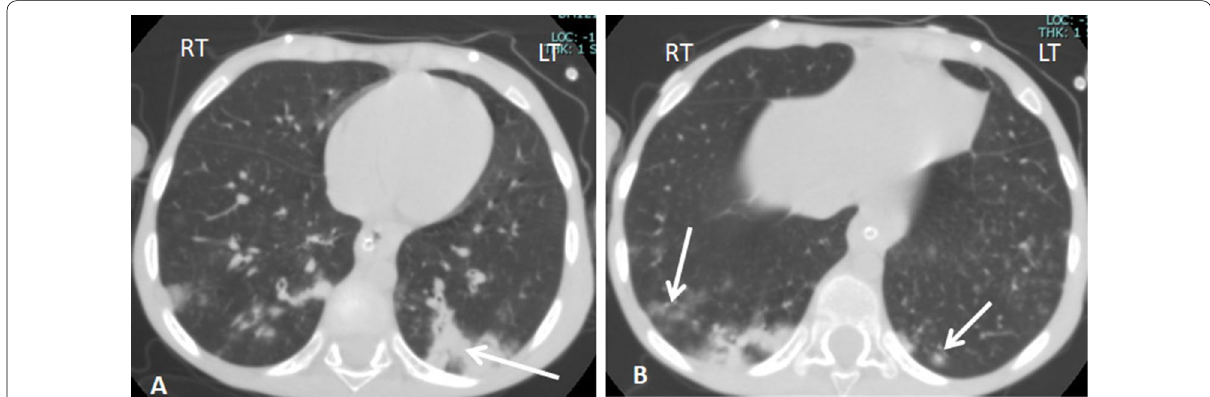
Fig. 6 A 5‑year‑old female child patient, a known case of medulloblastoma presented with fever and dyspnea for 7‑day duration; she had severe respiratory distress and was PCR positive. CT axial images showing bilateral scattered peripheral subpleural consolidations (arrow in A ), (arrows in B ) ground glass opacities in the right lung and halo sign in the left; picture is typical CT findings for COVID‑19, CT severity score 6/20